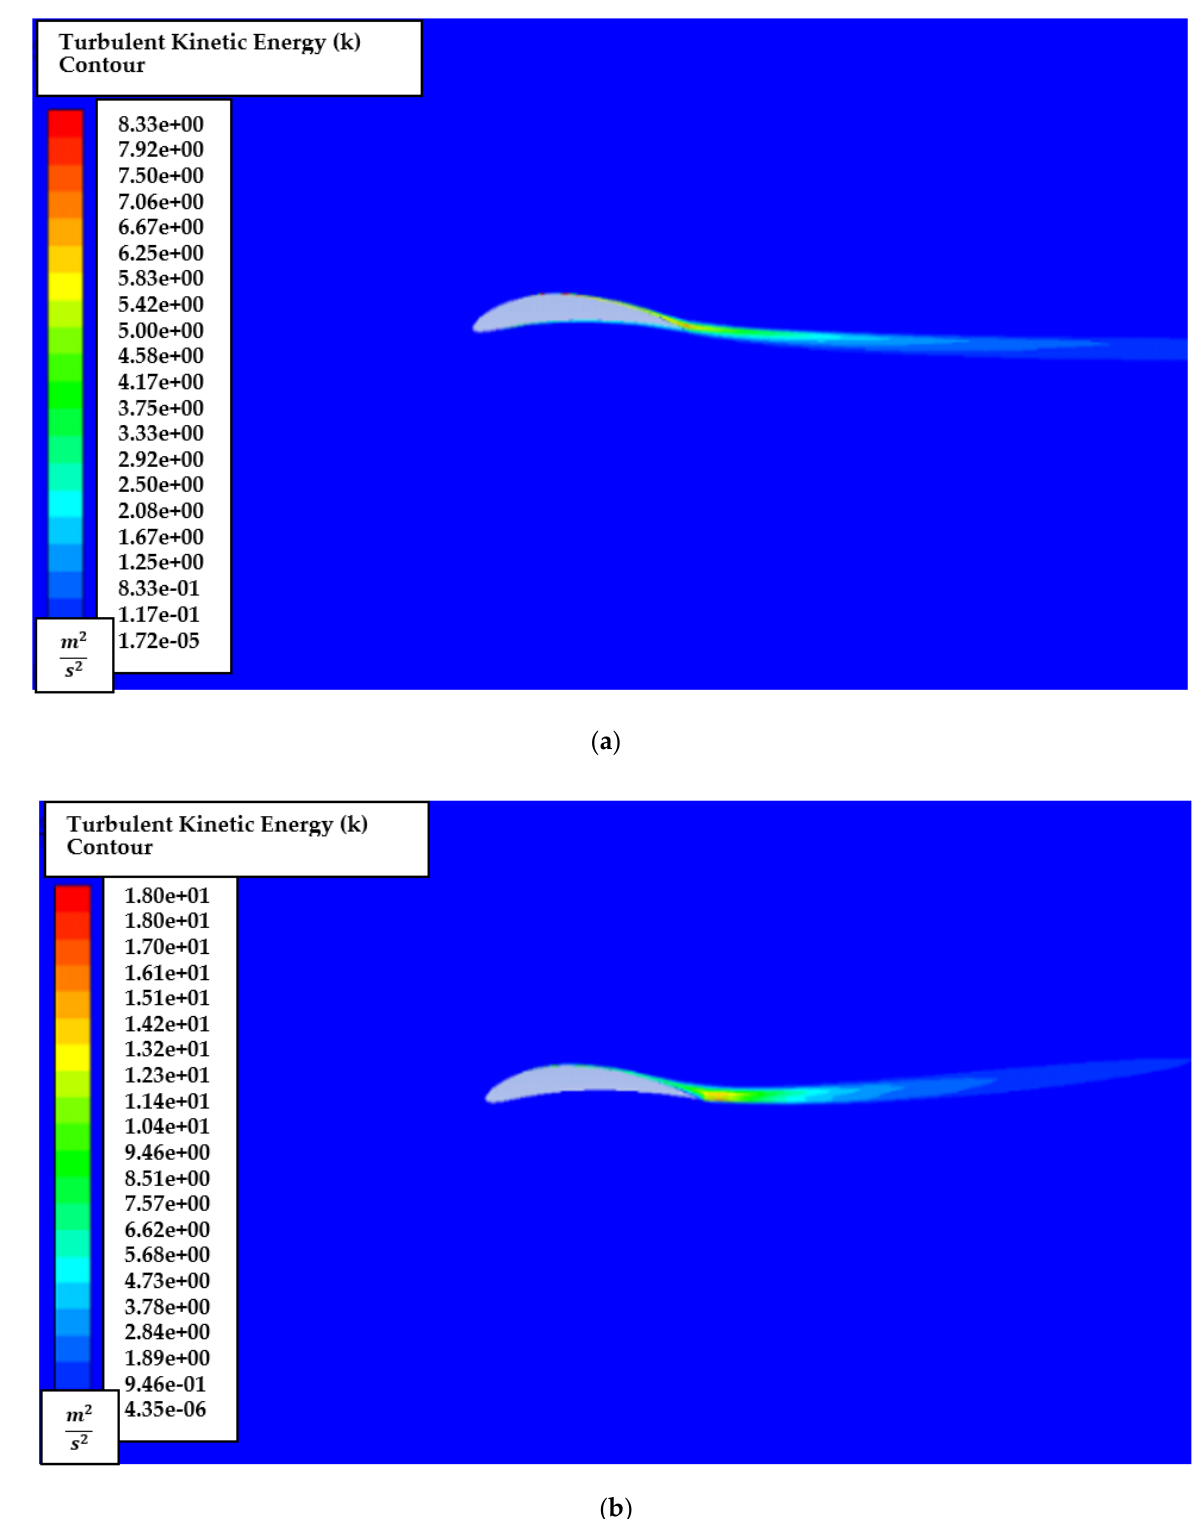
Figure 13. Velocity contour of NACA8410 with AoA ( a ) 1° and ( b ) 8°. The effects of turbulent kinetic energy are also explored by generating turbulent ki- netic energy contours for angles of attacks of 1° and 8°, as shown in Figure 14. It is also noted that turbulent energy is mainly dense near the trailing edge and downstream in low and high AoA.